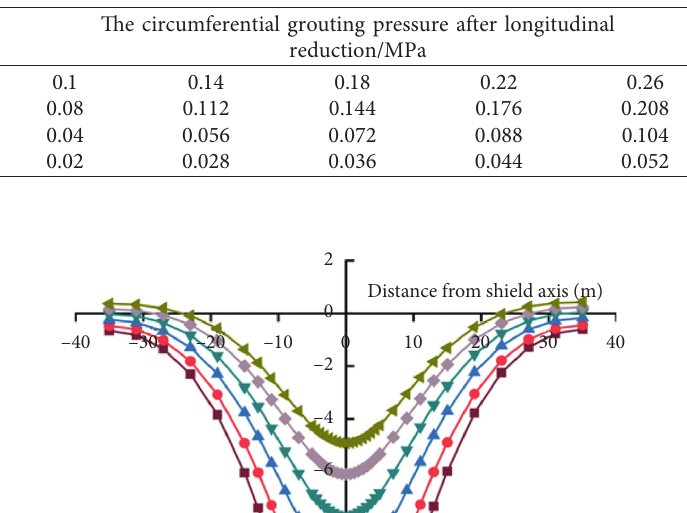
Table 11: Reduction coefficient of longitudinal grouting pressure.